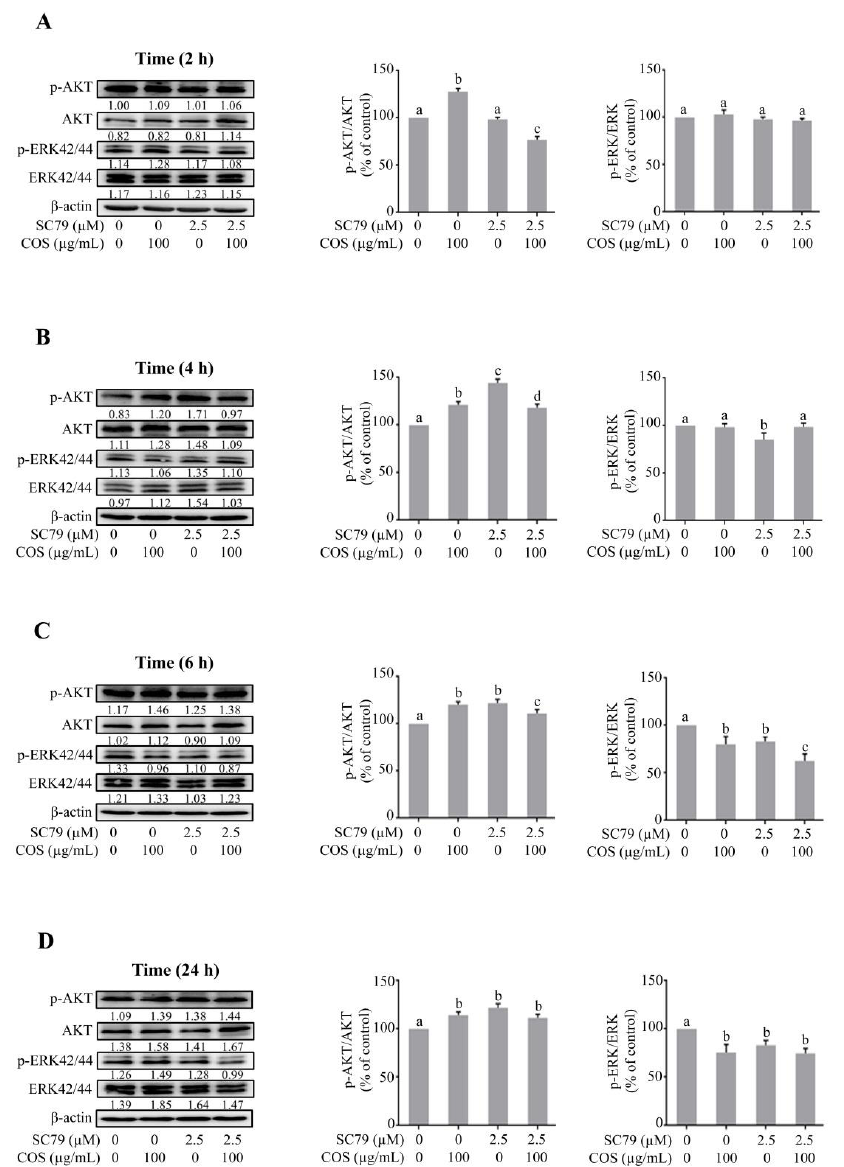
Figure 6. Effect of COS on AKT and ERK phosphorylation studied using SC79. ( A ) T84 cells were treated with the indicated concentrations of COS, SC79, either alone or in combination for 2 h ( A ), 4 h ( B ), 6 h ( C ), or 24 h ( D ). Data were analyzed as the ratio of p-AKT/AKT, p-ERK/ERK and expressed as % of control (vehicle-treated group), means ± S.D. ( n = 3). Columns not sharing the same superscript letters differ significantly ( p < 0.05, one-way ANOVA, Tukey’s post hoc test).